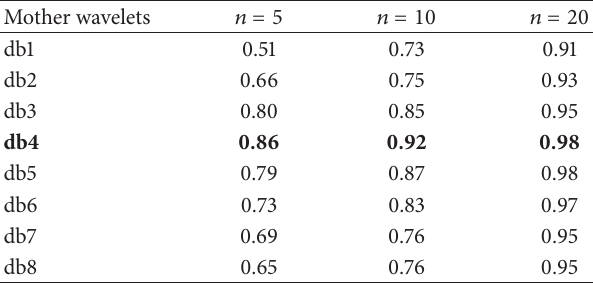
Table 2: The NPEs of the DWT using different mother